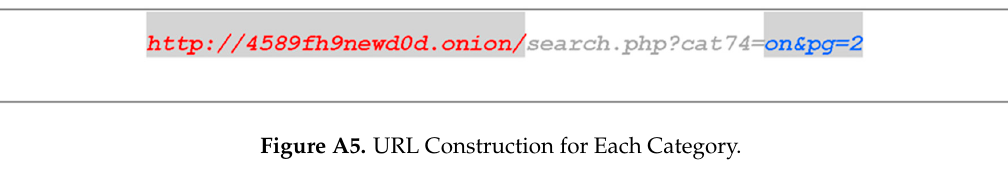
Figure A4. Sample HTML Tags from a Selected Marketplace Listing.